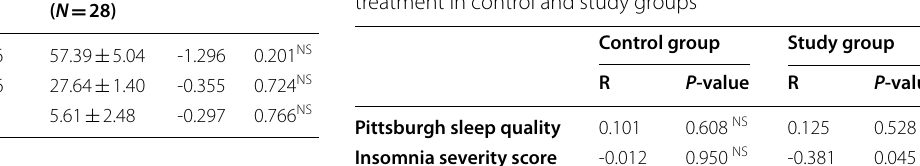
Data are expressed as mean